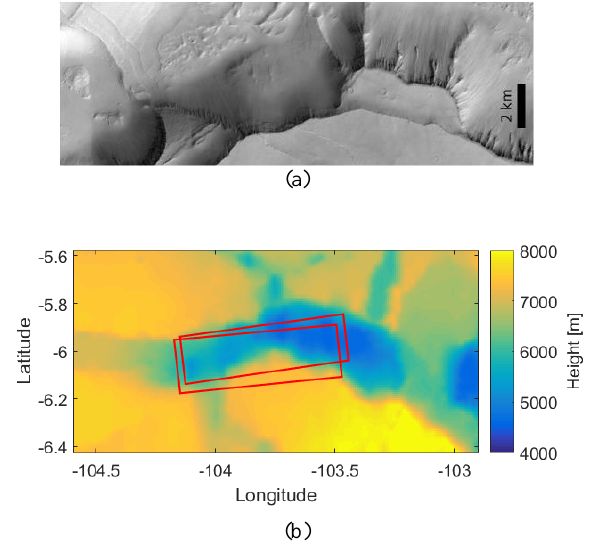
Figure 2 In (a) a mosaicked image of the first CaSSIS images, in (b) the on-ground footprints of the composed CaSSIS images. The footprints are depicted on the MOLA reference model.